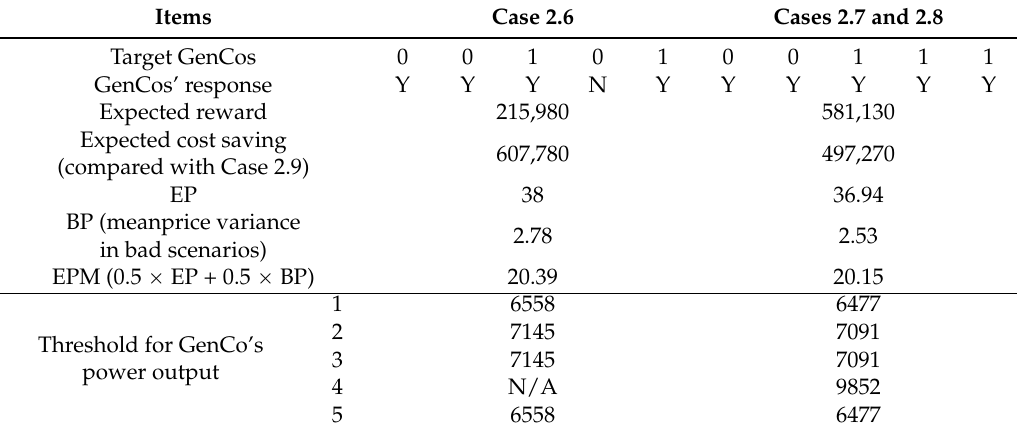
Table 6. Comparative results for Cases 2.6–2.8 (unit: $, N/A = Not